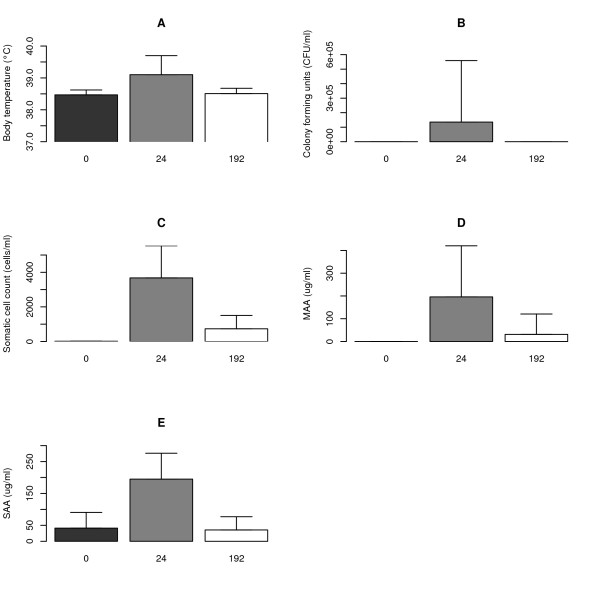
Overview of the clinical examination and para-clinical measurement of the cows infected with E. coli at T = 0 h (black), T = 24 h (grey) and T = 192 h (white). The bars correspond to the mean values of the trait, while the whiskers on the bars correspond to the standard deviation. A: body temperature of the cows (°C), B: number of E. coli bacteria in the milk (CFU/ml), C: somatic cell count in the milk (cells/ml), D: concentration of Milk Amyloid A in milk (μg/ml), and E: concentration of Serum Amyloid A in blood (μg/ml).